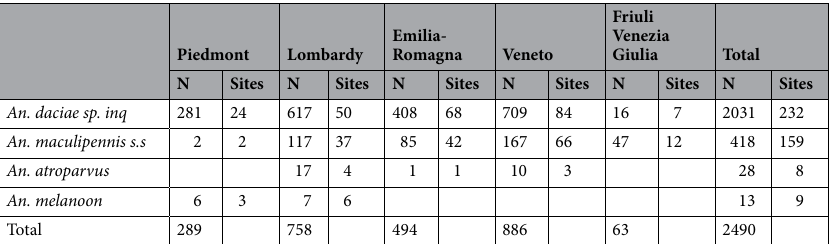
Table 1. Mosquitoes of the Maculipennis complex identified at species level with reference to the region of provenance and number of sites in which they were